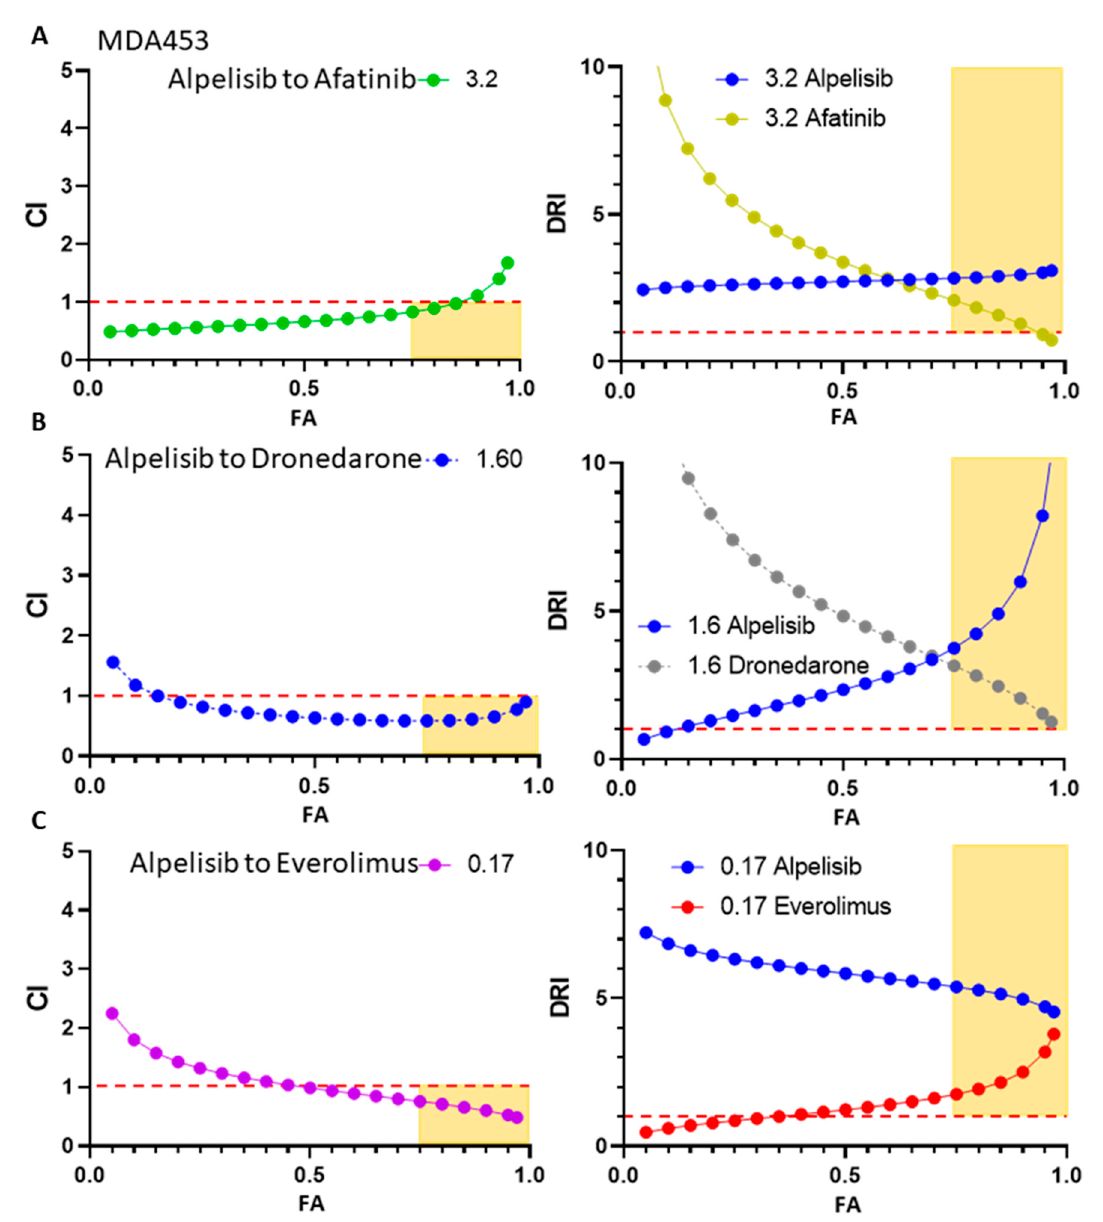
Figure 7. Compusyn was utilized to confirm synergism with higher rigor and to determine effective dose ratios in vitro on MDA453 cells. ( A ) Projected combination indexes per fractions affected for BYL-719 and afatinib and projected dose-reduction indexes per fractions affected for each drug at the dose ratio, BYL-719 to afatinib, listed. The same is shown for the combinations of BYL-719 with ( B ) dronedarone and ( C ) everolimus.